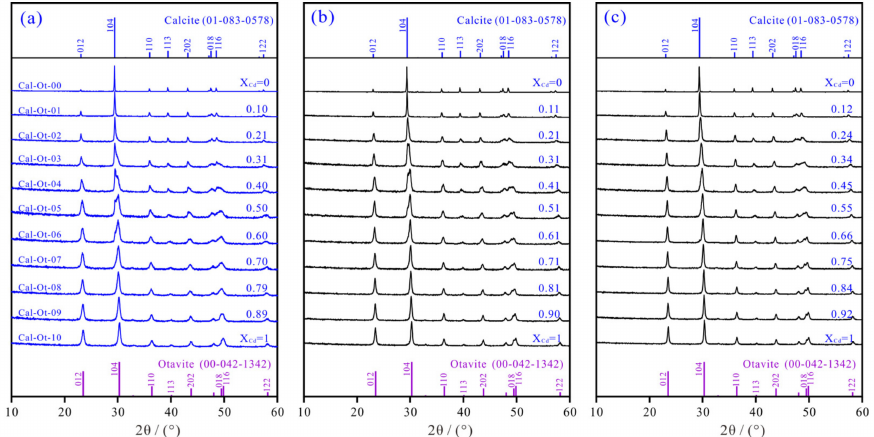
Figure 1. Diffraction patterns of the (Ca 1 − x Cd x )CO 3 solid solutions: ( a ) before dissolution and ( b ) after dissolution in the N 2 -degassed water for 270 d and ( c ) after dissolution in the CO 2 -saturated water for 270